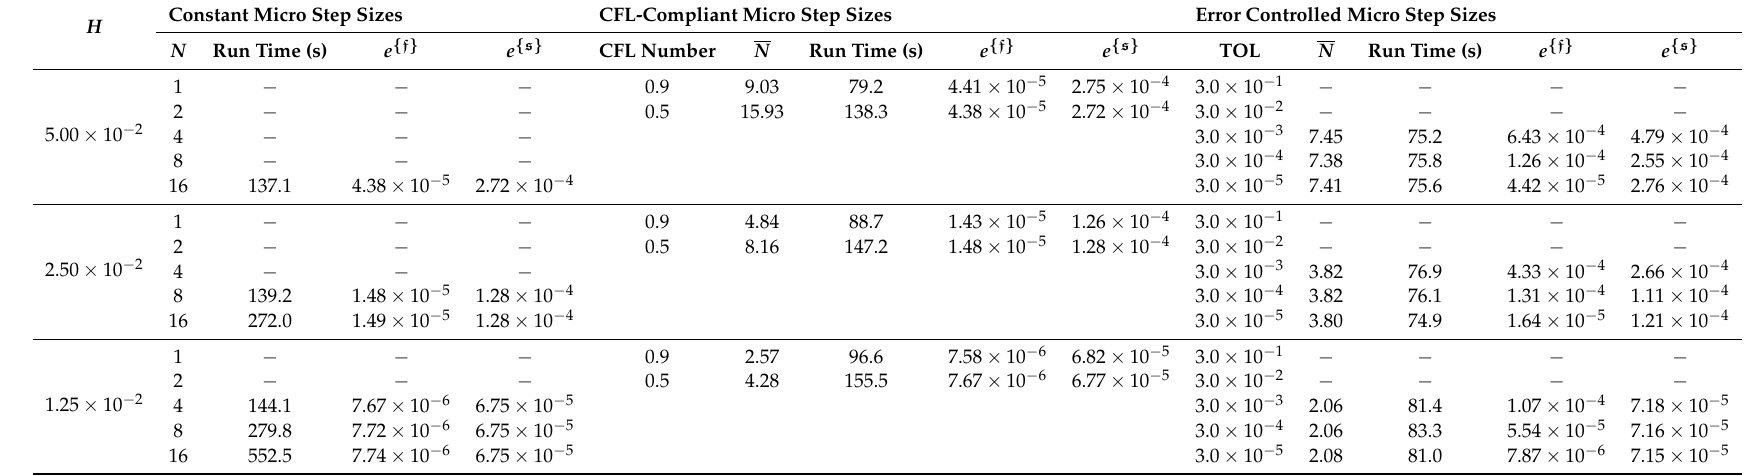
Table 2. Comparison of run time and error of different time step adaptation strategies of the 2nd order MGARK scheme applied to the piston problem, Part I. Further explanations are given in the text.